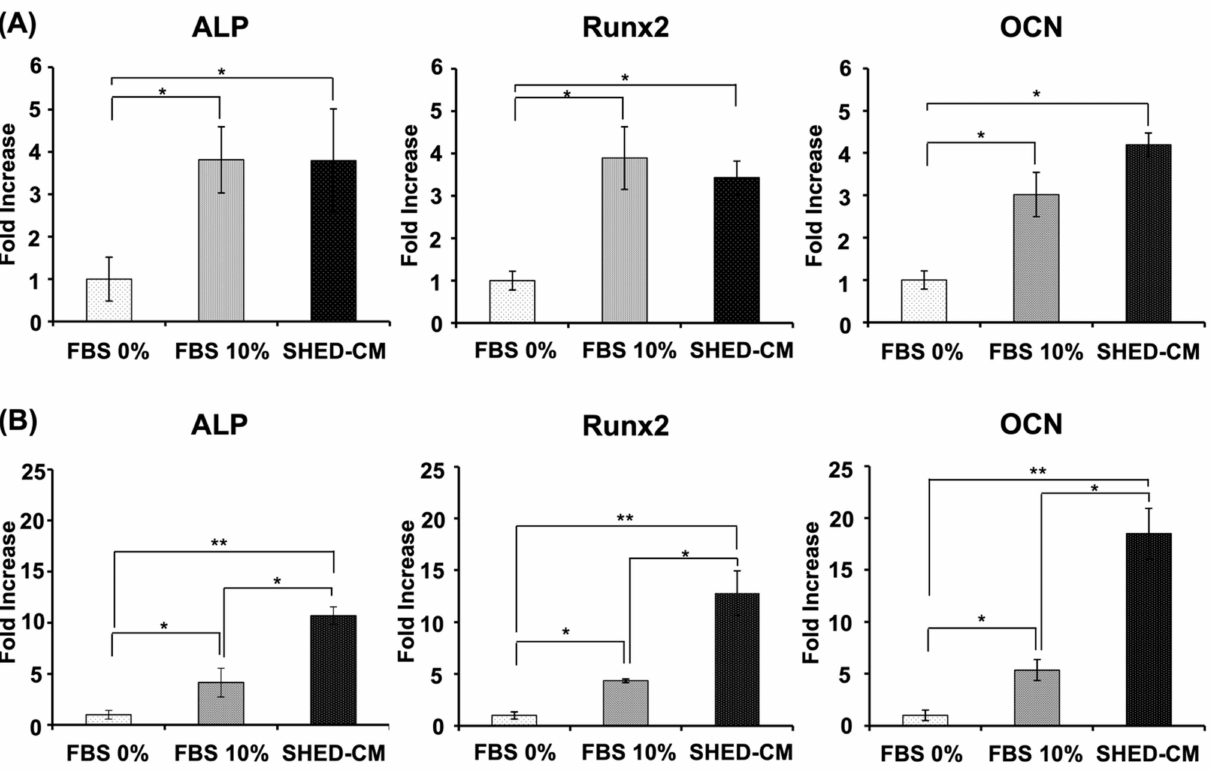
Figure 4. Effects of SHED-CM on hBMSCs and MC3T3-E1 gene expression. The expression of ALP , Runx2, and OCN was significantly enhanced in ( A ) hBMSCs and ( B ) MC3T3-E1 cells supplemented with SHED-CM or 10% FBS, compared with the 0% FBS group. The expression of ALP , RUNX2 , and OCN was significantly enhanced by SHED-CM supplementation in MC3T3-E1 cells compared with that in the 10% FBS groups. ( n = 3, ** p < 0.01, * p < 0.05). SHED-CM, human deciduous dental pulp-derived mesenchymal stem cell-derived culture